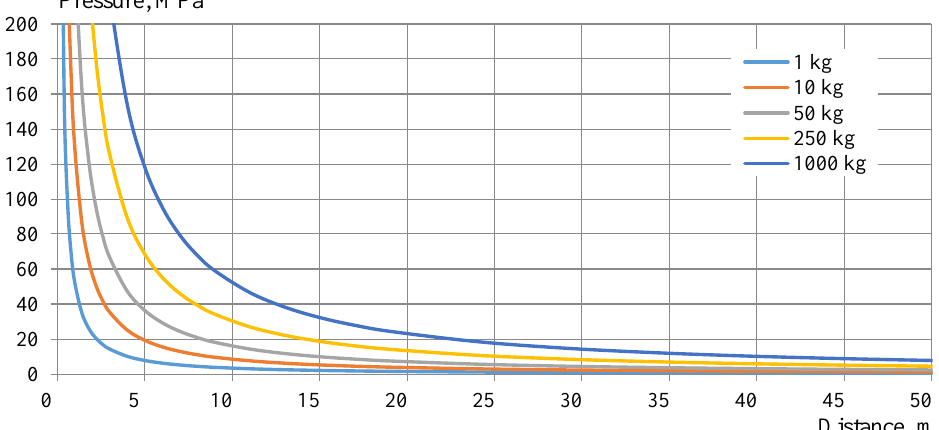
Figure 6. Pressure values on the shock wave front as a function of distance and TNT masses equal to 1, 10, 50, 250, 1000 kg according to T.L. Geers and K.S. Hunter.